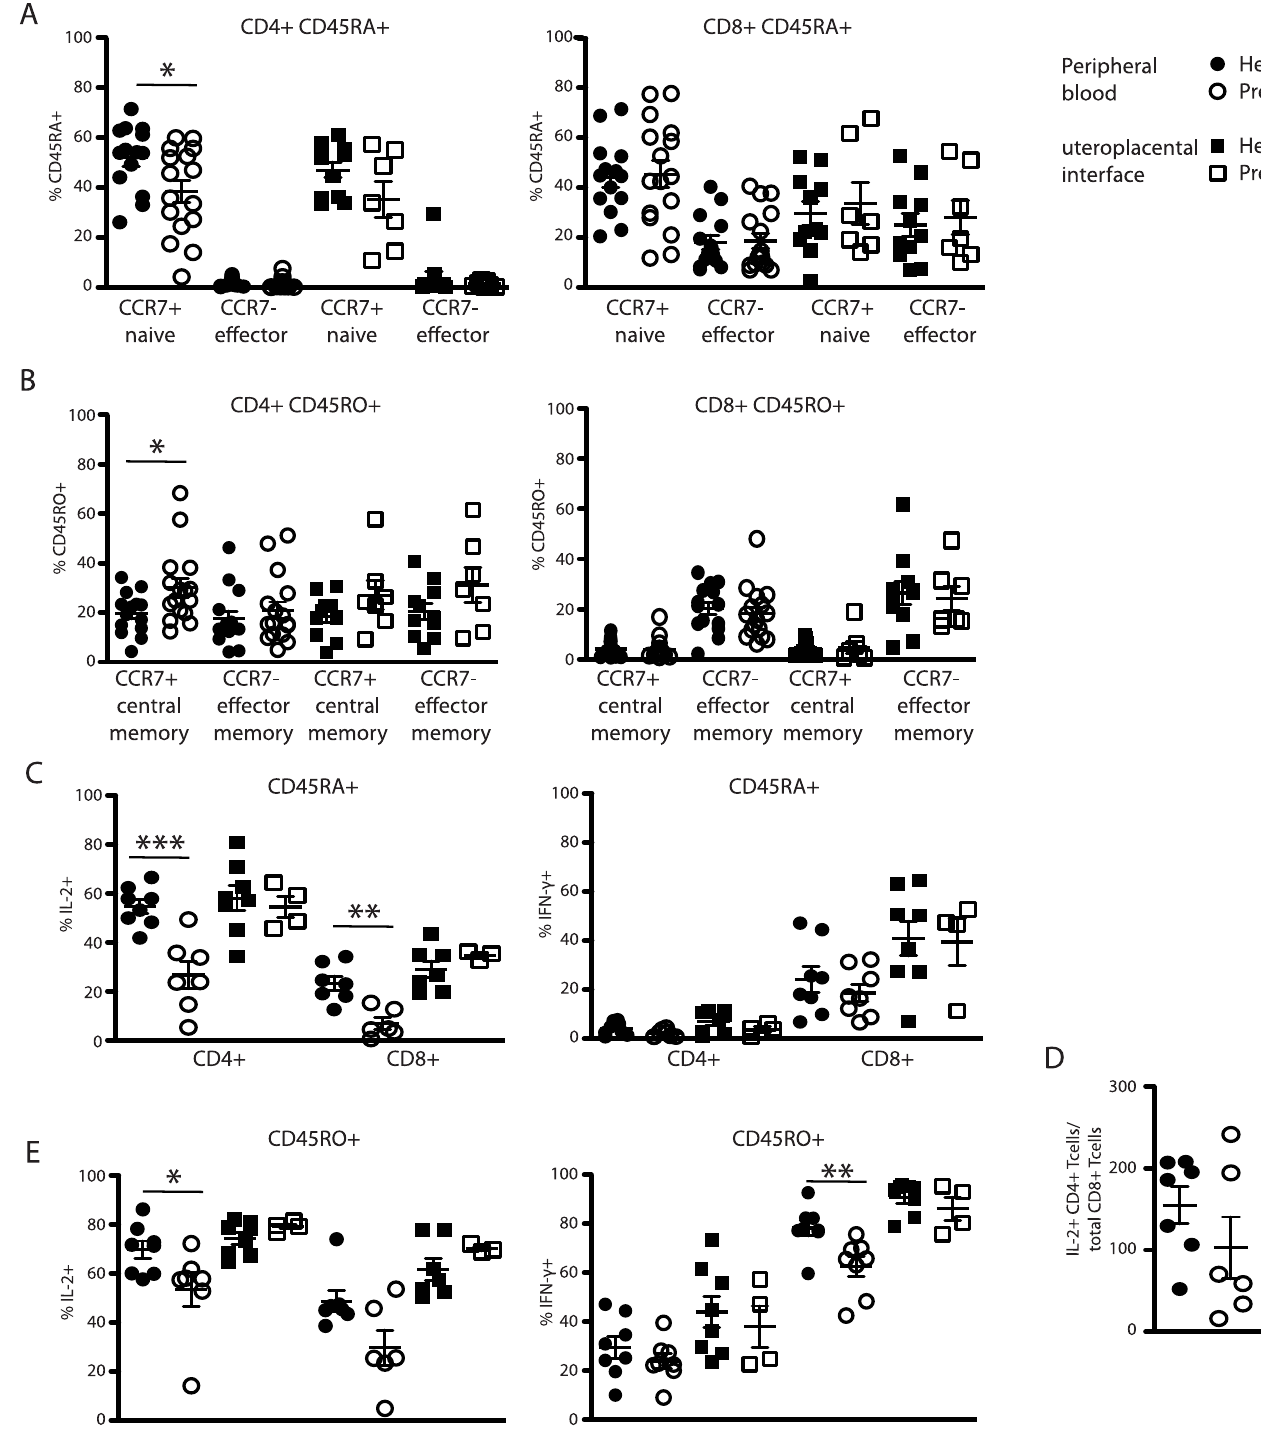
Fig 1. Na ï veCD4+ T cells in the peripheral blood of preeclamptic pregnant women are significantly reduced. Fresh peripheral blood and UPI samplesfrom healthy3 rd trimester pregnantwomen and preeclamptic women were processedand analyzedas describedin Materialsand Methods. Gated starting with Fig 1B lymphocyte gate and subjectedto Fig 1A Steps 2–5. (A, B) CD4+ (left side) or CD8+ (right side), CCR7+or–, CD45RA+(A) or CD45RO+ (B) sub-populations were identified as previously described[7]. (C, E) Intracellular cytokine staining of na ï ve(C) and memory (E) CD4+ and CD8+ T cells. PB (circles) or UPI lymphocytes (squares) were culturedfor 4.5h as describedin Materialsand Methods includingPMA/Ionomycin and Golgi Plug treatment. (E)